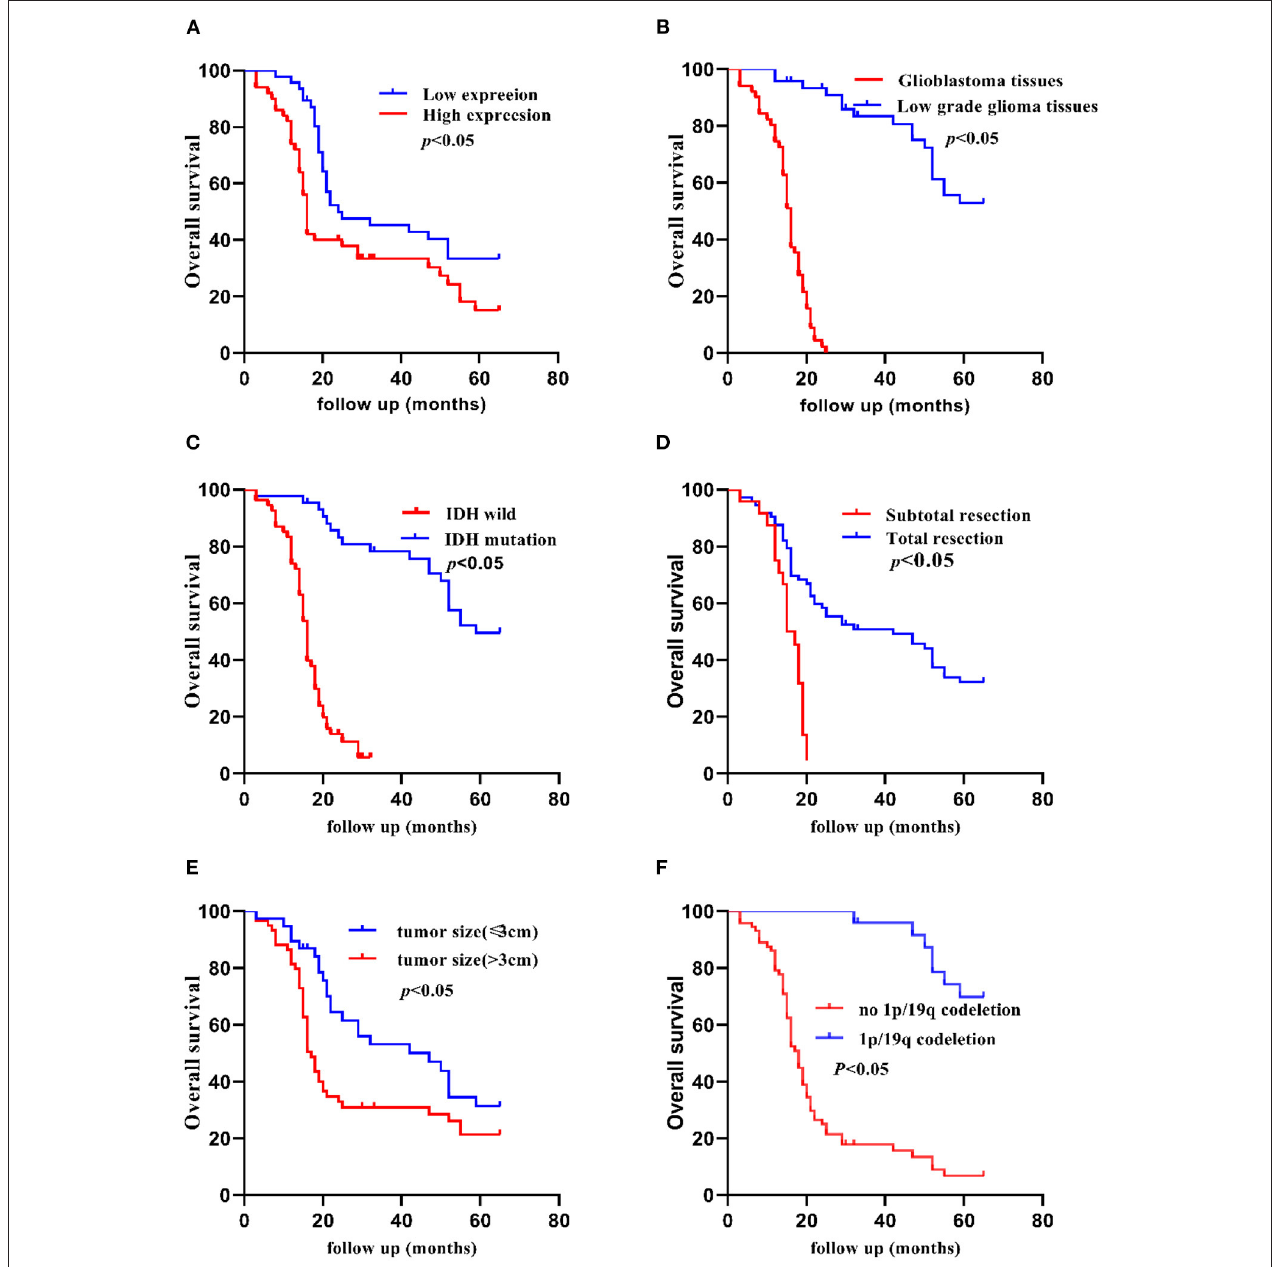
FIGURE 2 | Kaplan-Meier 5-year OS curves of patients with glioma according to clinicopathological features. (A) Patients with higher TCF7L2 expression showed shorter OS compared with those with a lower expression ( p = 0.010), (B) Glioblastoma patients showed worse OS compared with low-grade patients ( p = 0.001). (C) Patients with IDH wild-type showed worse OS compared with those with an IDH mutation ( p = 0.010). (D) Patients who had a subtotal resection showed worse OS compared with those who had a total resection ( p = 0.010). (E) Patients with a larger tumor size ( > 3cm) showed worse OS compared with those with a small tumor size ( ≤ 3cm) ( p = 0.020). (F) Patients with no 1p/19q codeletion showed worse OS compared with those with 1p/19q codeletion ( p =